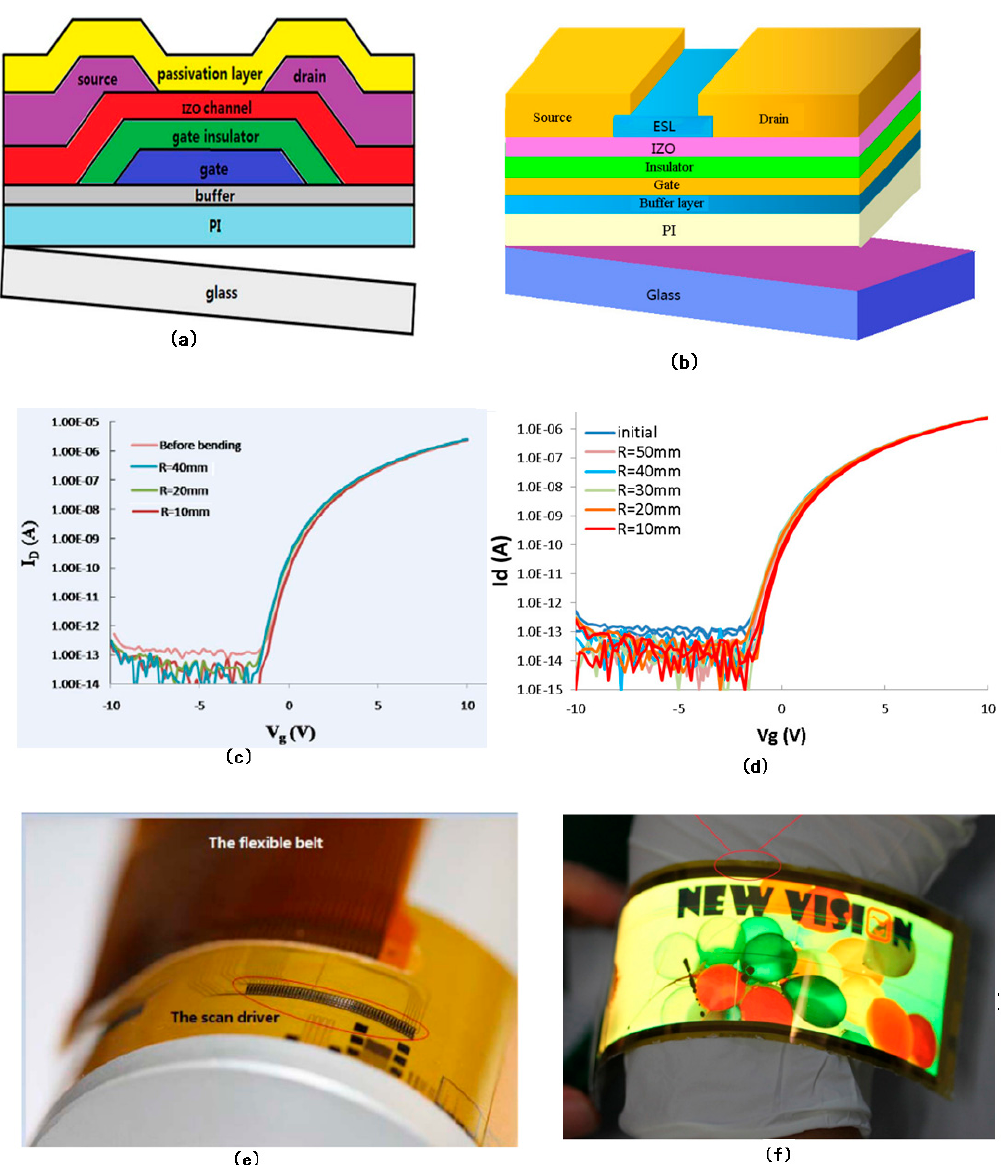
Figure 9. ( a ) and ( b ), schematic of BCE TFT and ESL TFT, ( c ) and ( d ), transfer characteristic of BCE TFT and ESL TFT, ( e ) and ( f ) application of BCE TFT and ESL TFT [161,162].